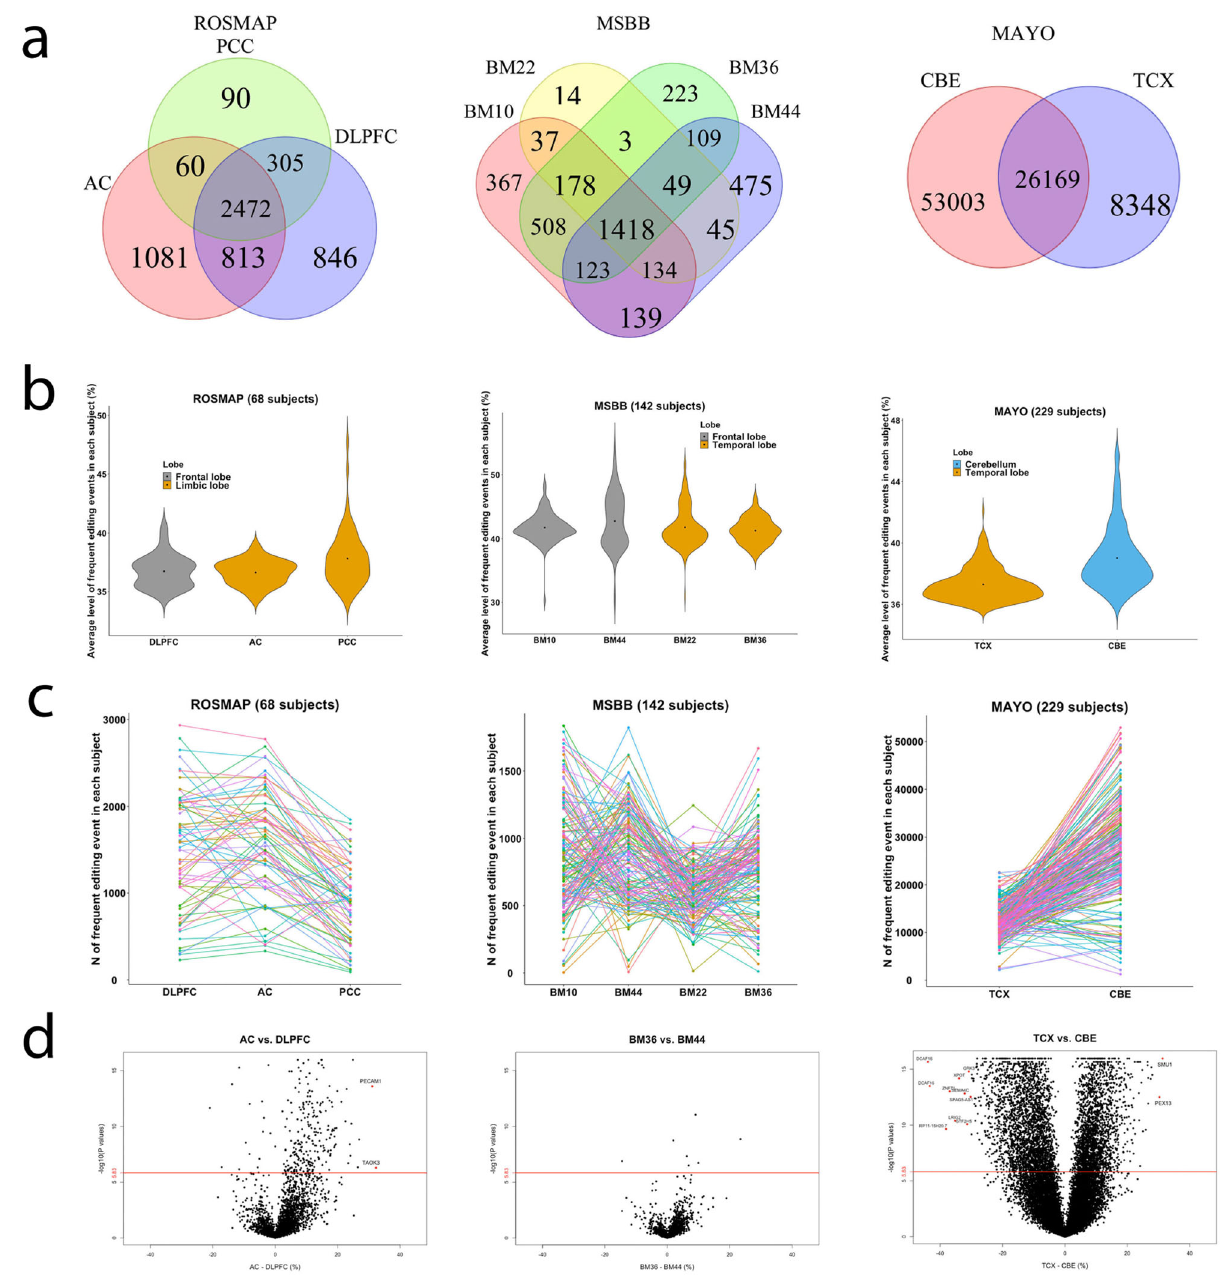
Fig. 3 Distributions of frequent RNA editing events across brain regions. a Venn diagrams show the number of frequent ( ≥ 10%) RNA editing events present in different regions within different studies. b Violin plots show the distribution of the per sample values of the average level of all frequent RNA editing events. c The total number of frequent RNA editing events called within each subject across different regions. Each line represents one subject while the connection dots represent the number of frequent RNA editing events called in that subject for the corresponding region. d Volcano plots show the differences between 2 tested brain regions in the level (% alternative reads) of each RNA editing event (shown as one dot). X and Y axes display the regression coef fi cient and its corresponding − log10 transformed P value from the mixed linear regression model with the subject as random effect and fi xed covariates of age at death, sex, postmortem interval, and RIN score. The displayed P values were not adjusted by the multiple testings and were derived by two-sided tests. The red horizontal line showed the Bonferroni-corrected P value threshold of 1.49 × 10 − 6 (0.05/33,641). The red dots with annotated gene names are those RNA editing events with P ≤ 1.49 × 10 − 6 and regression coef fi cient of the differences between 2 brain regions ≥